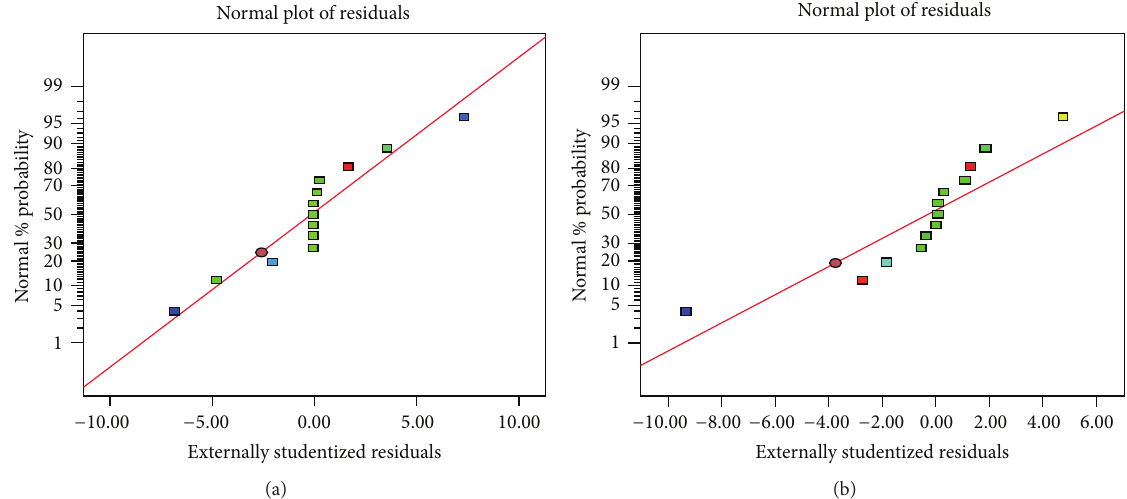
Figure 6: Design Expert plot. Normal probability plot of the standardized residual for NUE (a) and NU (b).